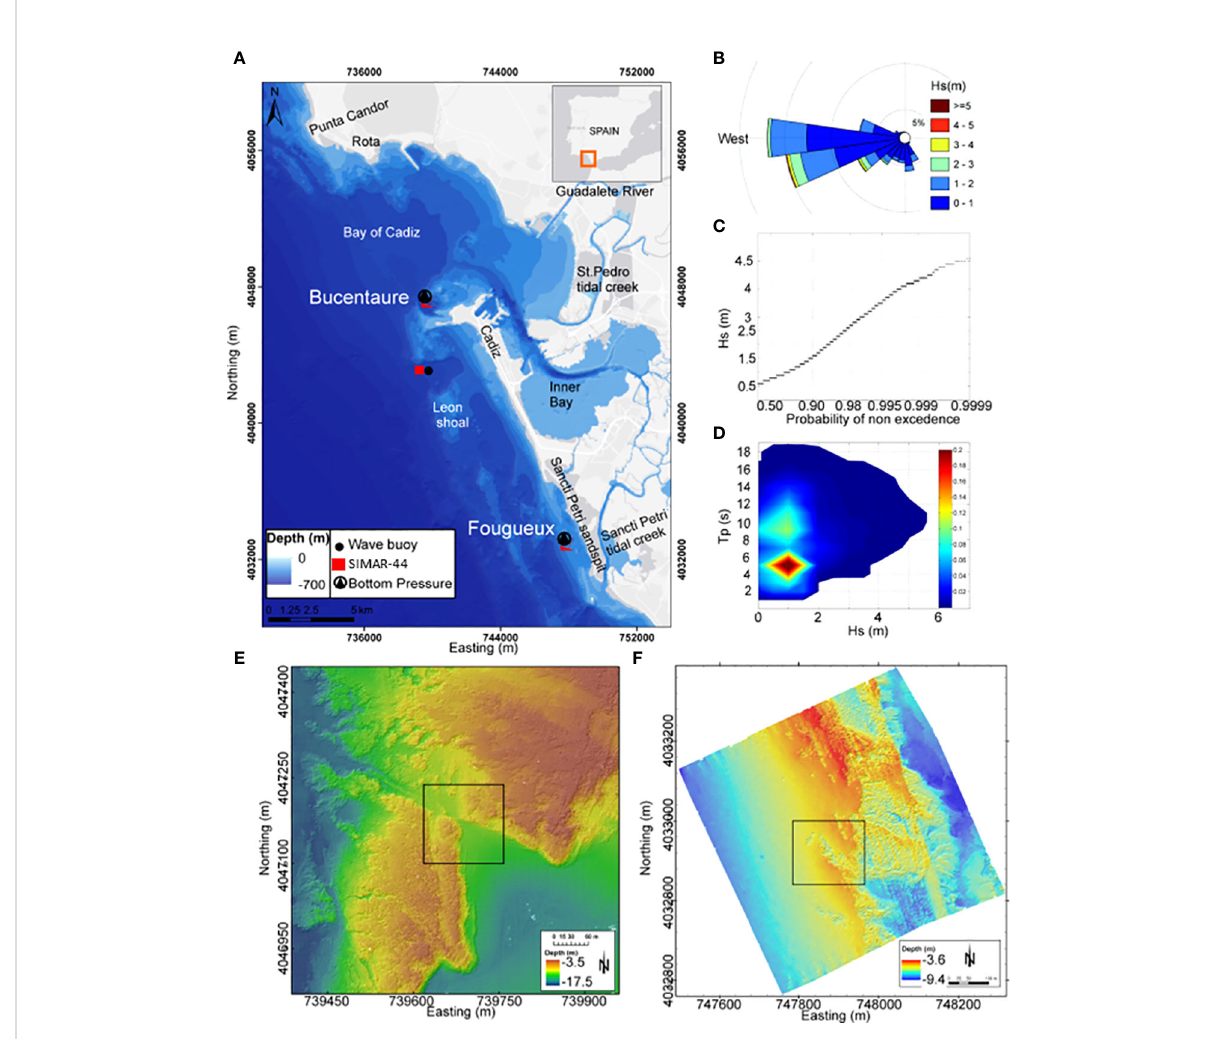
FIGURE 1 (A) Location of the studied sites. (B) Wave rose diagram of signi fi cant wave-height for directional wave buoy. (C) Scalar wave climate of signi fi cant wave height. (D) Joint distribution of signi fi cant wave height (Hs) and peak period (Tp). (E) Bathymetry of the Bucentaure site. (F) Bathymetry of the Fougeux site (Ferna ́ ndez-Montblanc et al,